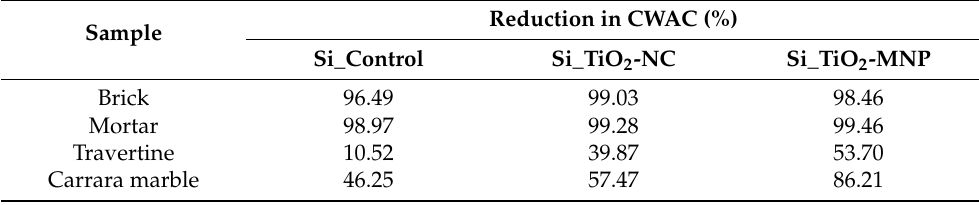
Table 3. Reduction (%) of the capillary water absorption coefficient (CWAC), due to the coating.